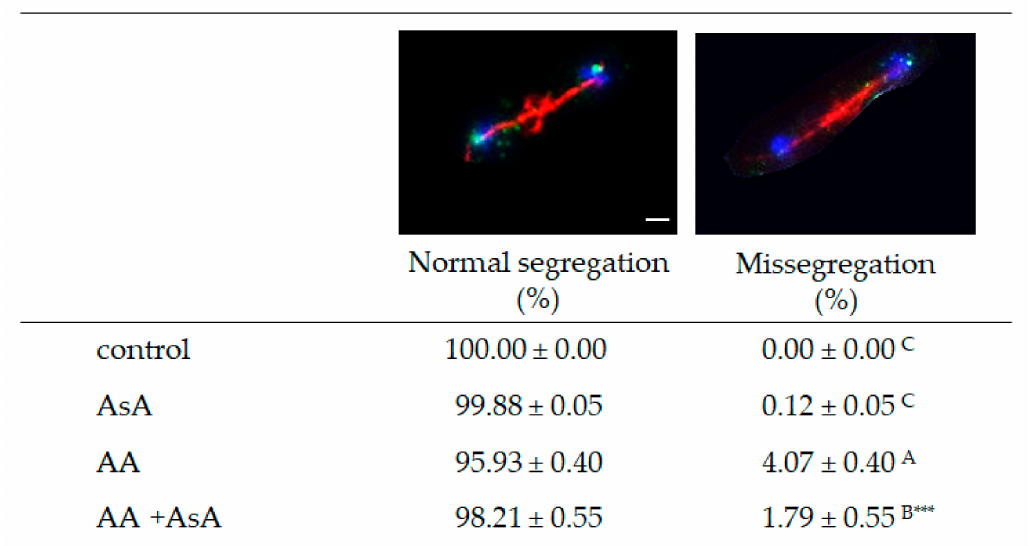
Figure 8. Chromosome segregation during mitosis. Segregation of chromosome II during mitosis was analyzed in cells exposed to 20 mM AA for 6 h with and without 10 mM AsA pre-treatment. Control cells were grown in YES medium without AA and AsA addition. At least 200 cells from 4 inde-pendent experiments were scored for normal or missegregated chromosome II and expressed in percent. Statistical significance is determined by Duncan’s post-hoc test, different letters above bars indicate statistical difference. Significance of statistical differences are indicated as p < 0.001